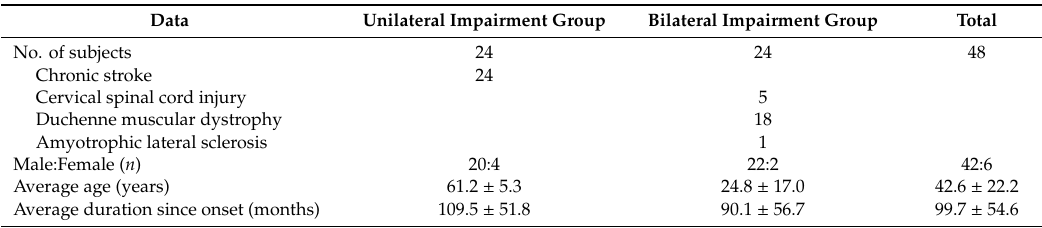
Table 1. Demographic data of survey